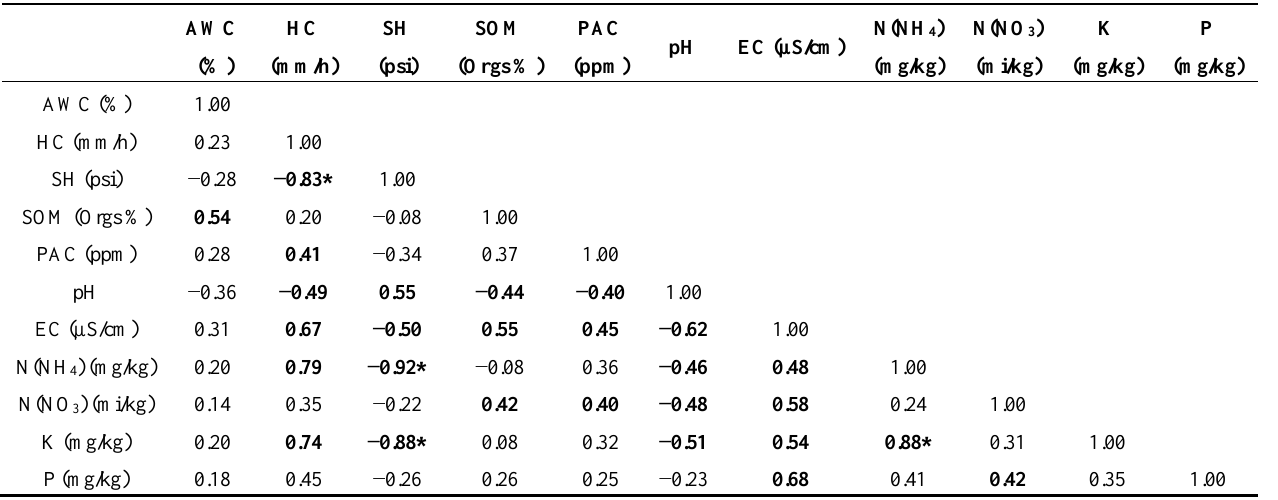
Table 2. Pearson correlation coefficients for the measured soil quality properties in the Migda site, Israel. Bold numbers indicate significant differences with p ≤ 0.05 and bold numbers with (*) indicate highly significant differences with R ≥ 0.8 and p ≤